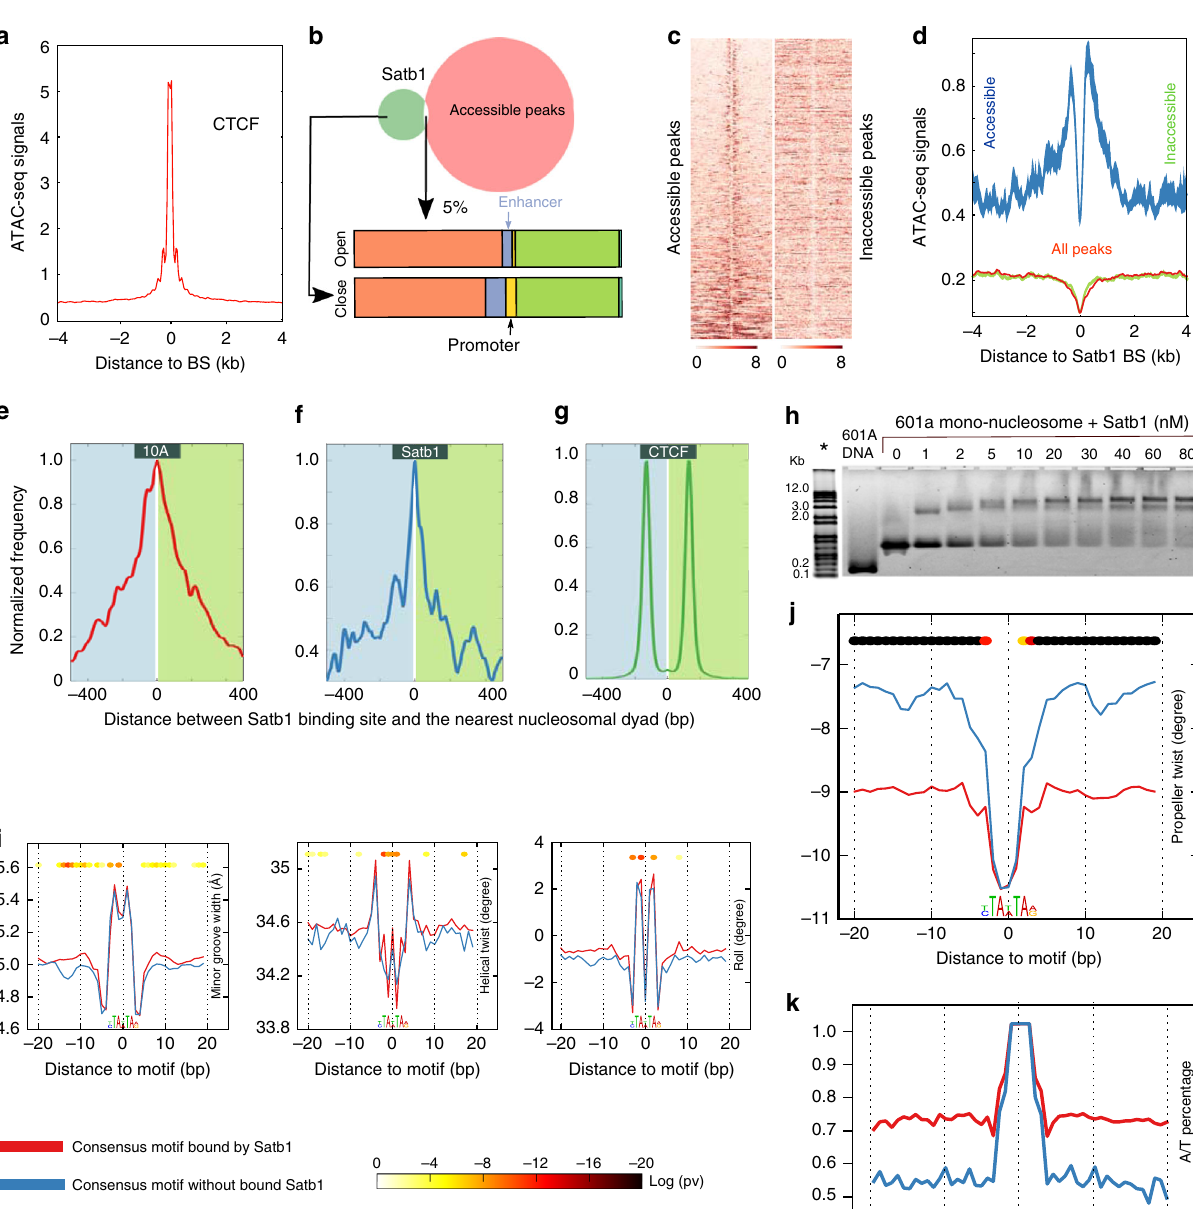
Fig. 3 High nucleosome-density and negative propeller twist characterize Satb1 binding sites. a The average of ATAC-seq signal from an 8 kb window centered on CTCF binding sites in transposase accessible and inaccessible regions of the genome. b Genome annotation for accessible (~5% of all binding sites) and inaccessible Satb1 binding sites (~95% of all binding sites). c The ATAC-seq signal from an 8 kb window centered on Satb1 binding sites in transposase accessible and inaccessible regions of the genome. d The average of tagmentation signals at Satb1 binding sites in accessible and inaccessible regions. e, f Distribution of distances from nucleosomal dyad to Satb1 binding centers in native MCF-10A cells which lack Satb1 ( e ) and cells expressing exogenous Satb1 ( f ). g Distribution of distances from nucleosomal dyad to CTCF binding centers in MCF-10A cells. h 601 A nucleosome-EMSA shows that Satb1 binds ef fi ciently to nucleosome-core embedded consensus motif resulting in 3 distinctly shifted populations, each increment presumably representing binding to one of the sites incorporated in SH3, SH4, and SH6. The ladder (* aligned) image was obtained by staining the EMSA gel with SYBR Green after the fl uorescence image was acquired in the Alexa 488 channel. i, j Line plots showing average of MGW, HelT, Roll ( i ) and ProT ( j ) values across 40 bp windows centered on consensus motifs bound by FL Satb1 in nucleosome free regions ( n = 1968) compared to consensus motifs free of Satb1 (down sampled from n = 3039). k Line plots showing average percent A/T content across the same 40 bp windows as i, j . p -values in i, j are obtained using Mann-Whitney U test. Note: Total number of motifs is much larger than total number of CHIP-seq peaks, since many binding sites have more than one motif. Source data are provided as a Source Data fi